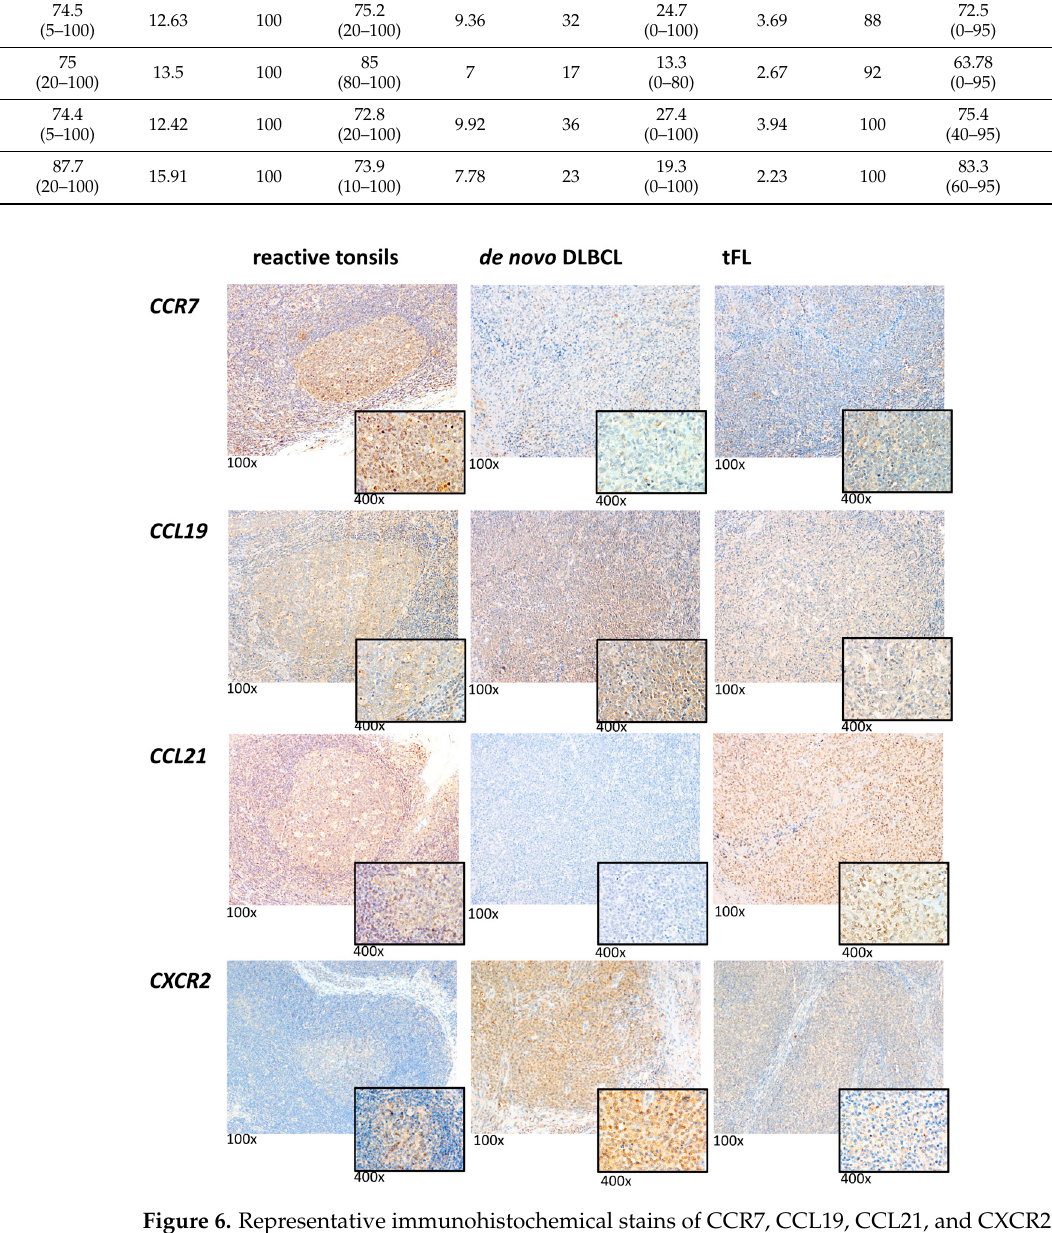
Figure 6. Representative immunohistochemical stains of CCR7, CCL19, CCL21, and CXCR2 expres- sion in reactive tonsils, de novo DLBCL, and tFL. All images were captured using an Olympus BX51 microscope and an Olympus E-330 camera (magnification 100× for the overview and magnification 400× for the small picture).